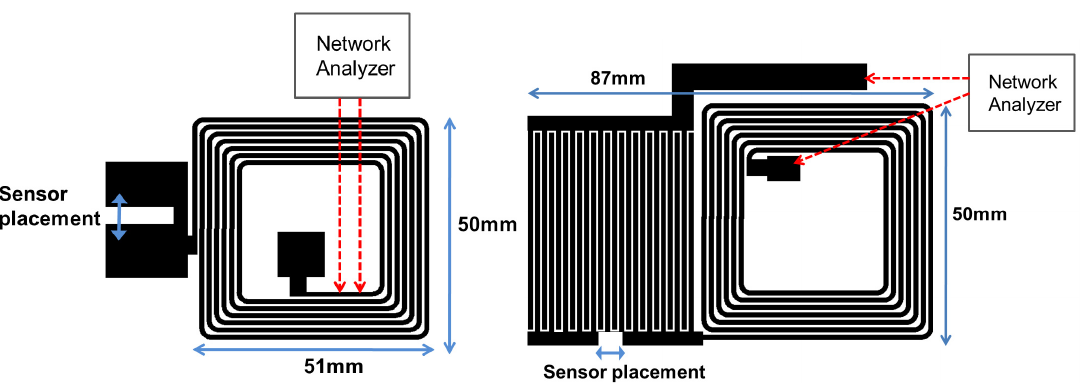
Figure 4. Top layer layout of the parallel plate capacitor LCCR EAS tag (left) and interdigital version (right) showing dimensions and the placement of the